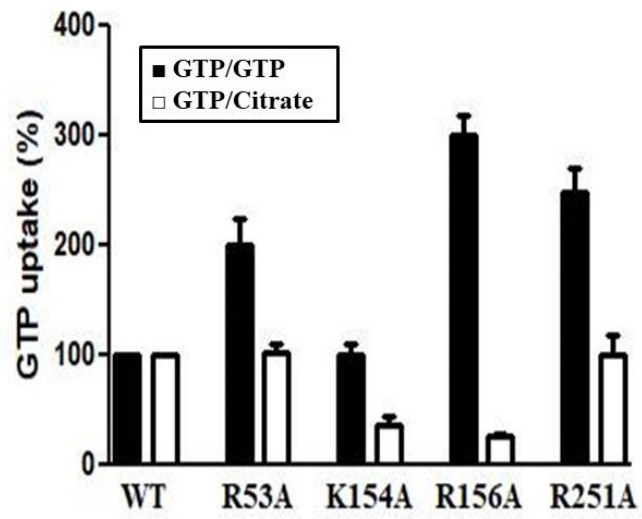
Figure 10. [8- 3 H] GTP uptake in proteoliposomes reconstituted with recombinant wild-type or mutant Ggc1p. Transport was started by adding 1 µ M [8- 3 H] GTP to proteoliposomes containing internal 5 mM GTP (antiport, black columns) or 5 mM citrate (CIGU, white columns) and stopped after 20 s. The uptake of WT Ggc1p was considerated 100%.